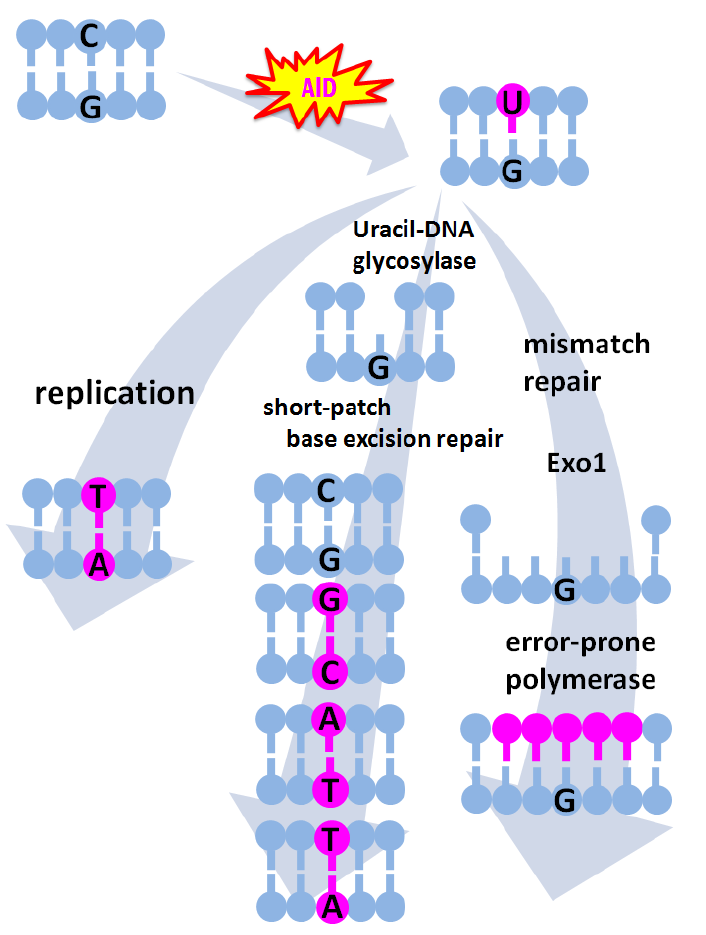
Figure 1. Activation-induced cytidine deaminase (AID) induces genetic changes in human DNA sequences. AID converts cytosine (C) to uracil (U) on the target DNA sequence, creating U-guanine (G) mismatch that is resolved by several pathways. (Left pathway) The general replication machinery interprets U as if it was thymine (T), generating C to T and G to adenine (A) mutations. (Middle pathway) Uracil-DNA glycosylase removes an U nucleotide, creating an abasic site. Short-patch base excision repair fills the gap with error-prone polymerases, which can insert any nucleotide in place of the U nucleotide, leading to both transition and transversion mutations at C-G pairs. (Right pathway) Mismatch repair recognizes U-G mismatch. U-bearing strand is excised by Exo1 and error-prone polymerases fill the gap, leading to mutations at A-T pairs as well as at neighboring C-G